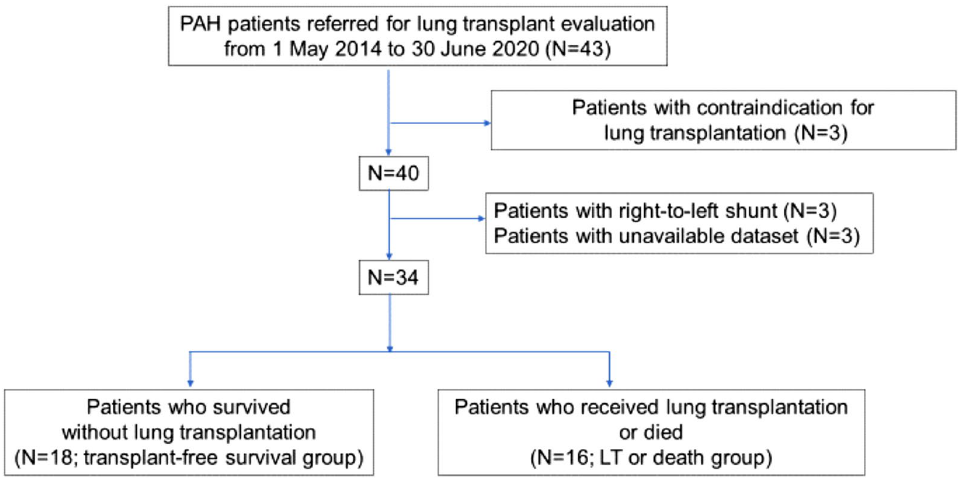
Figure 1. Flowchart of the study design, which included PAH patients referred for lung transplant evaluation. LT lung transplantation, PAH pulmonary arterial